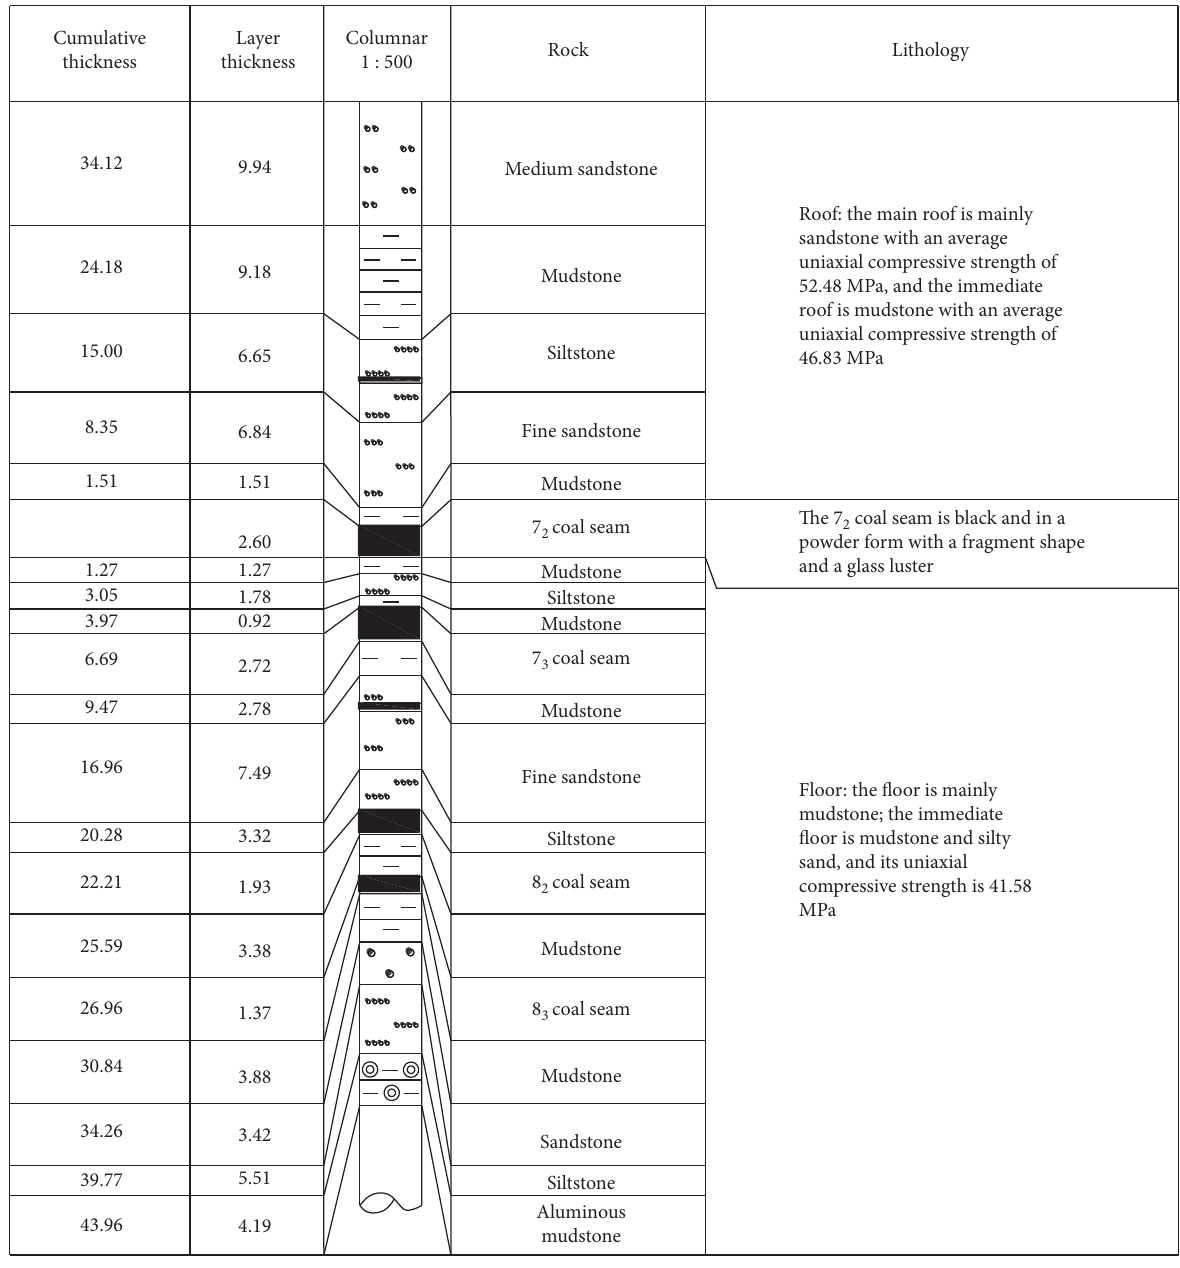
Figure 1: Geological columnar section.